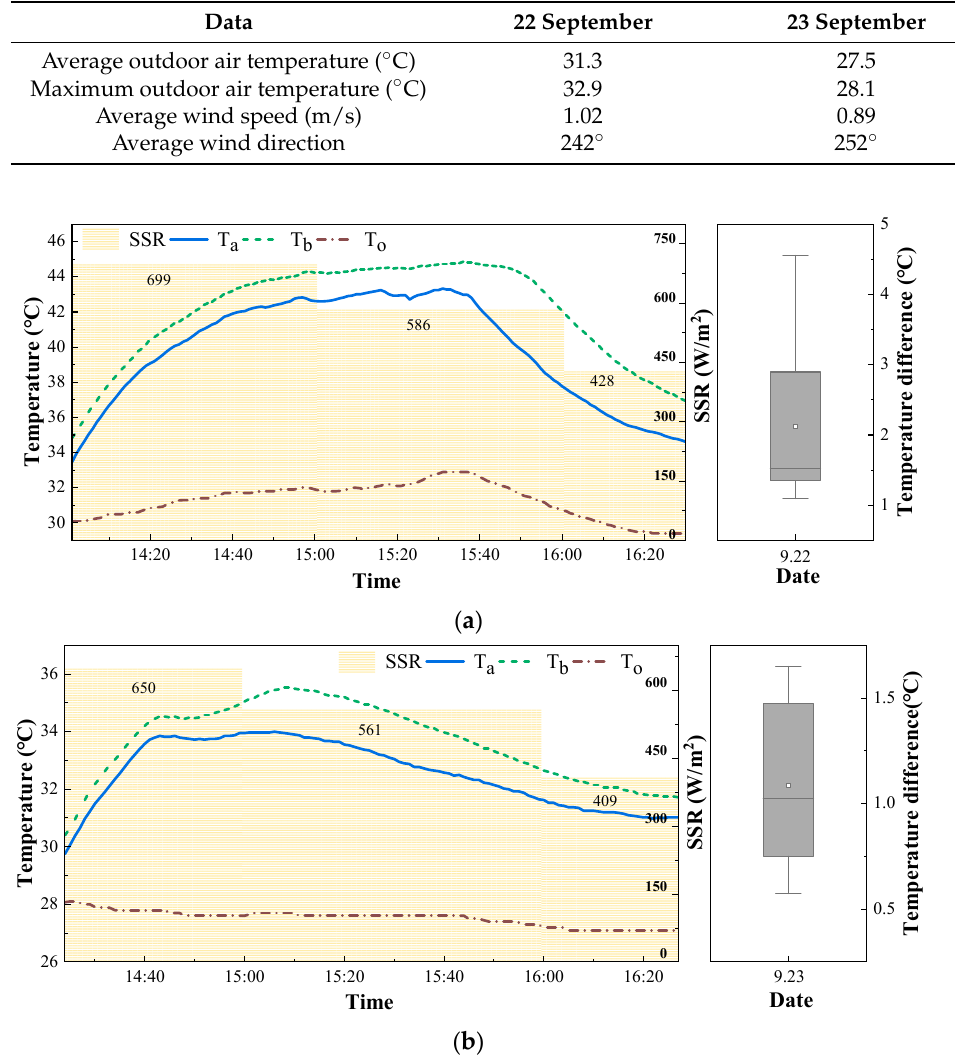
Figure 6. Variation of the air temperature of the vehicles on: ( a ) 22 September; ( b ) 23 September.